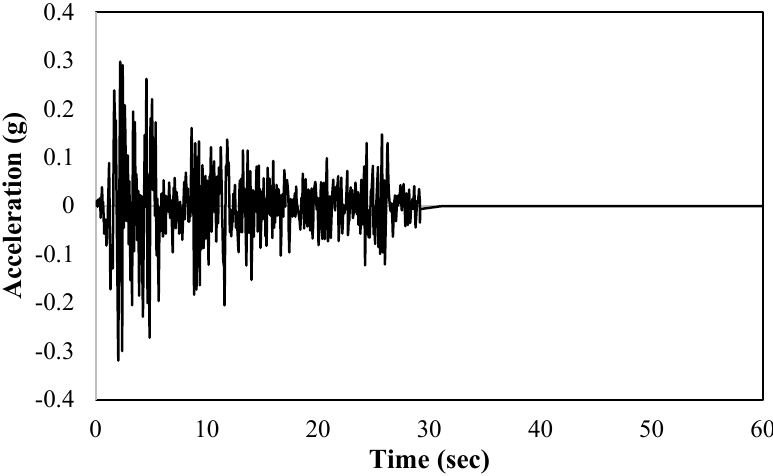
Time (sec) Figure 6. The El Centro earthquake’s ground motion: the horizontal component . Figure 6. The El Centro earthquake’s ground motion: the horizontal